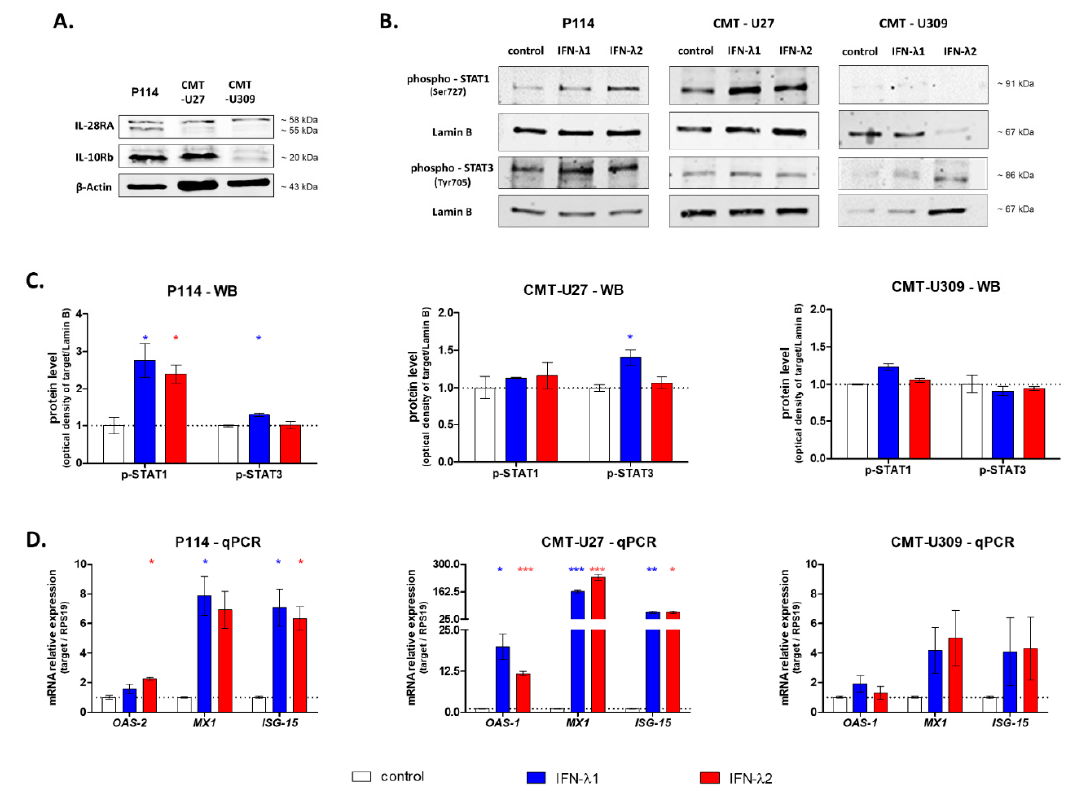
Figure 1. Representative images of Western blot showing the expression of IL-28RA, IL-10Rb and β -actin (loading control) in whole CMT cell lysates ( A ) and phospho-STAT1, phospho-STAT3 and Lamin B (loading control) in the nuclear fraction of CMT cells after 30 min treatment with IFN- λ 1 and IFN- λ 2 ( B ). The graphs showing the relative phosphorylation of STAT1 and STAT3 in CMT cells after 30 min treatment with IFN- λ 1 and IFN- λ 2 ( C ). The graphs showing the relative mRNA of ISG expression in CMT cells treated with IFN- λ 1 and IFN- λ 2 for 12 h ( D ). The results are presented as the mean ± SEM. A one-way ANOVA and Dunnet’s HSD post hoc test were applied. Significance levels are indicated as follows: * p < 0.05; ** p < 0.01; *** p <